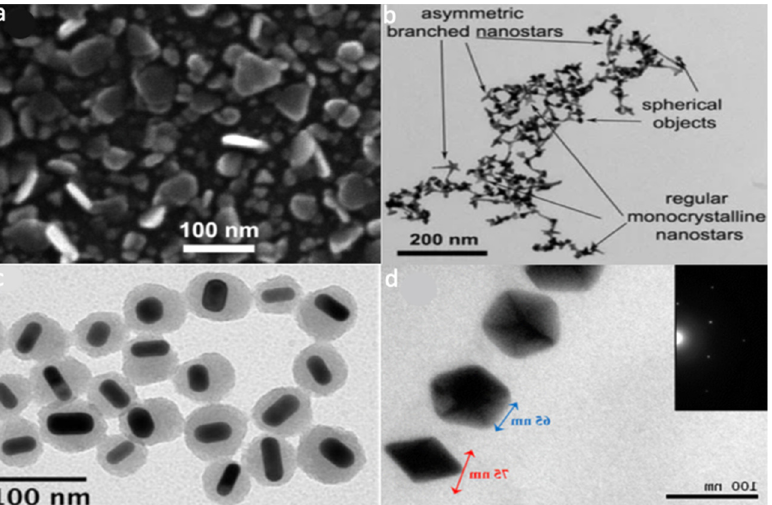
Figure 1. ( a ) SEM image of nano-plates Reprinted with permission from [39], copyright 2020, Elsevier B.V. ( b ) TEM image of nanostars. Reprinted with permission from [40] under Open Access Creative Common CC, license 4.0, to MDPI. ( c ) TEM image of nanorods. Reprinted with permission from [41], under Open Access Creative Common CC, license 4.0, to MDPI. ( d ) TEM image of pentagonal bipyramid nanoparticles. Reprinted with permission from [42], copyright 2016, American Chemical Society.